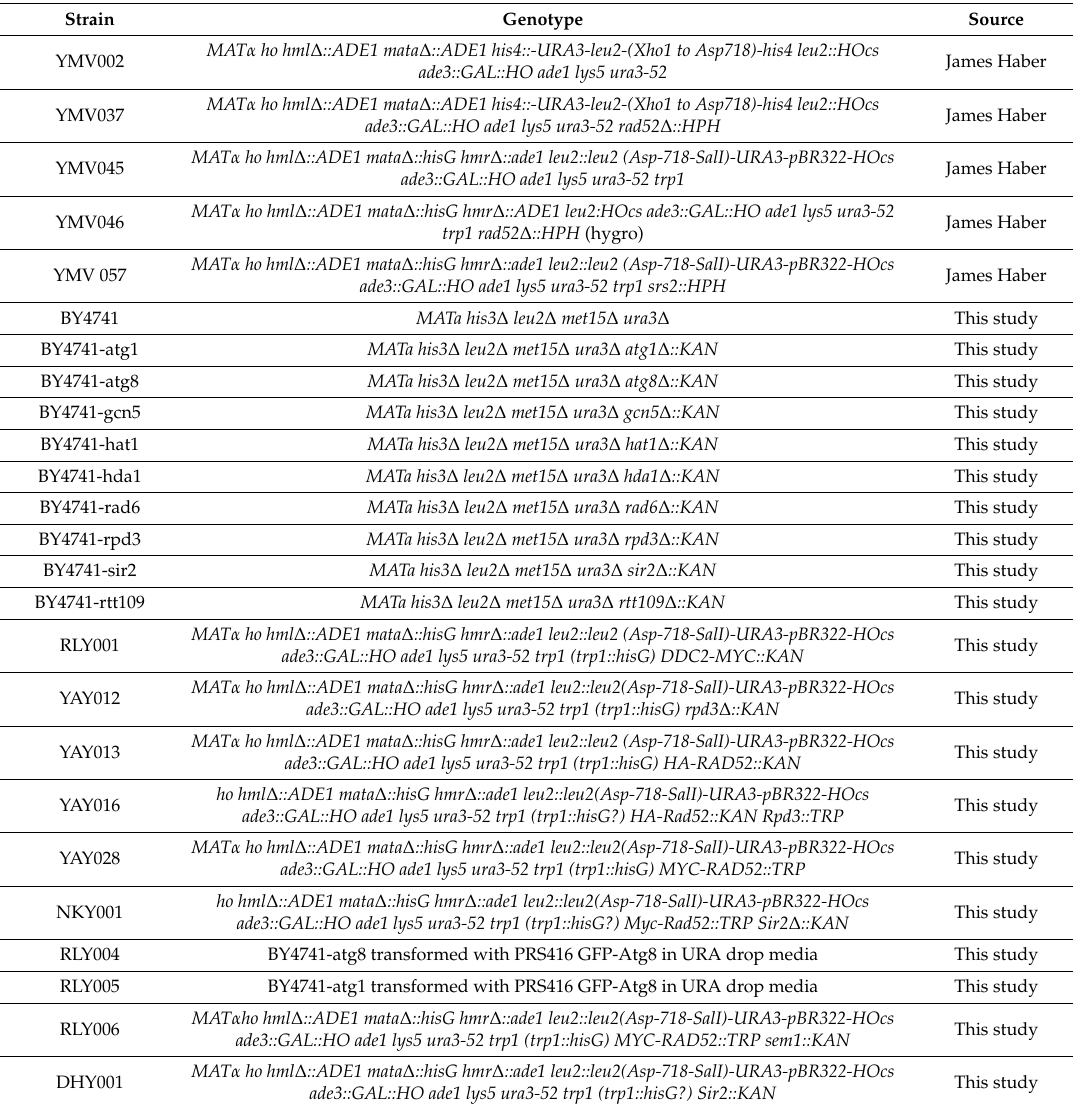
Table 1. Genotypes of yeast strains used in this